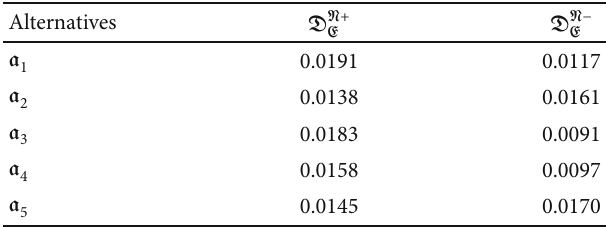
Table 9: Distance measure of each alternative.